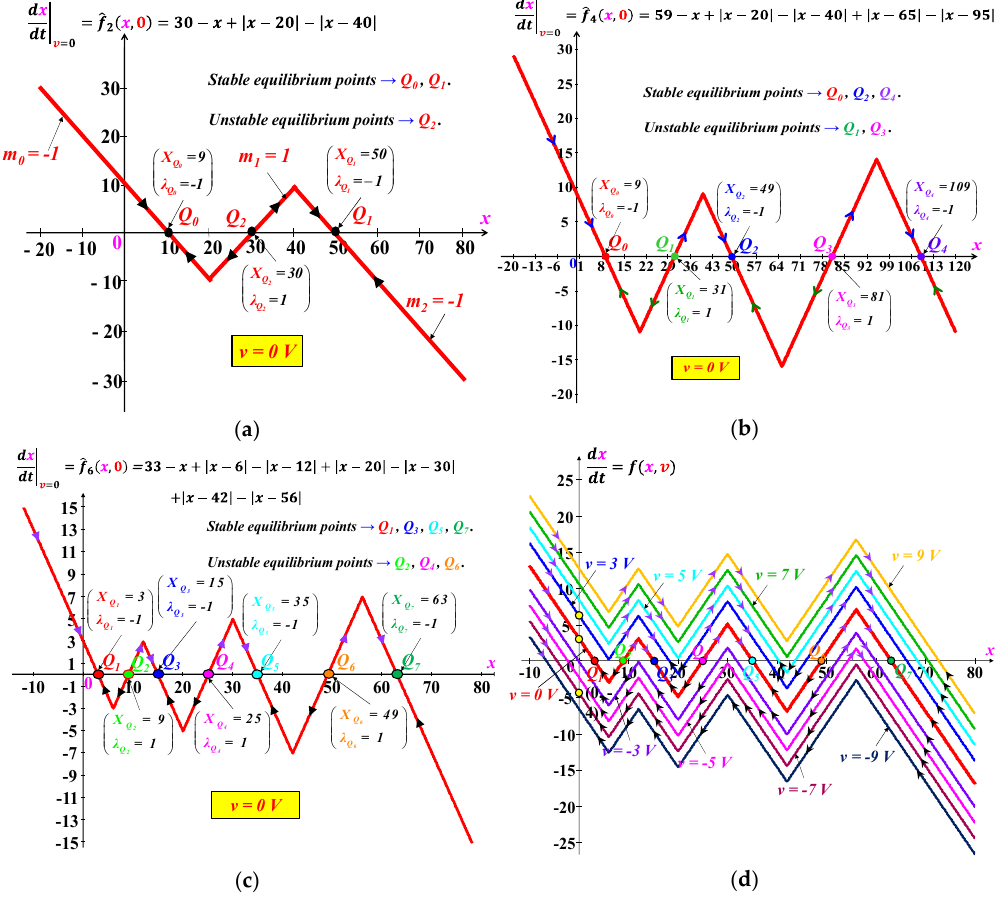
Figure 1. Dynamic route map ( DRM ) and power-off plot ( POP ) of Chua corsage memristors ( CCMs ). POP of ( a ) 2-lobe CCM , ( b ) 4-lobe CCM , ( c ) 6-lobe CCM , and ( d ) DRM of 6-lobe CCM .